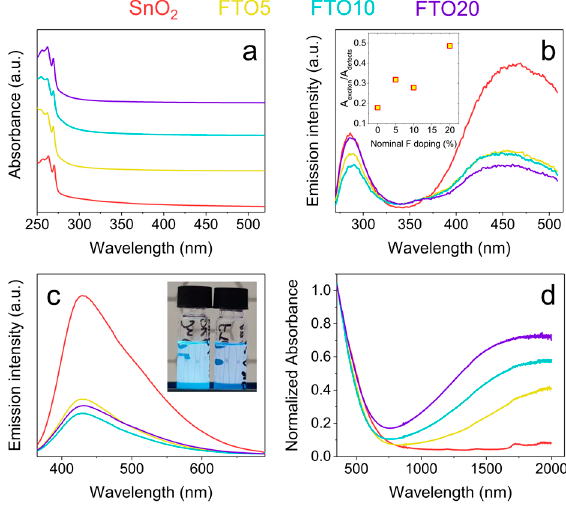
Figure 3. Optical characterization of SnO 2 and FTO NCs. ( a ) Optical absorption spectra in the UV-Vis region. The spectra are vertically offset for clarity. ( b ) Photoluminescence spectra with excitation at 260 nm. The inset shows the integrated ratio between the excitonic peak and the defect peak. ( c ) Photoluminescence spectra with excitation at 330 nm. The inset shows a digital photograph of SnO 2 (left) and FTO10 (right) colloids under UV illumination. ( d ) Absorption spectra in the UV-Vis-NIR showing a plasmon peak of increasing intensity.